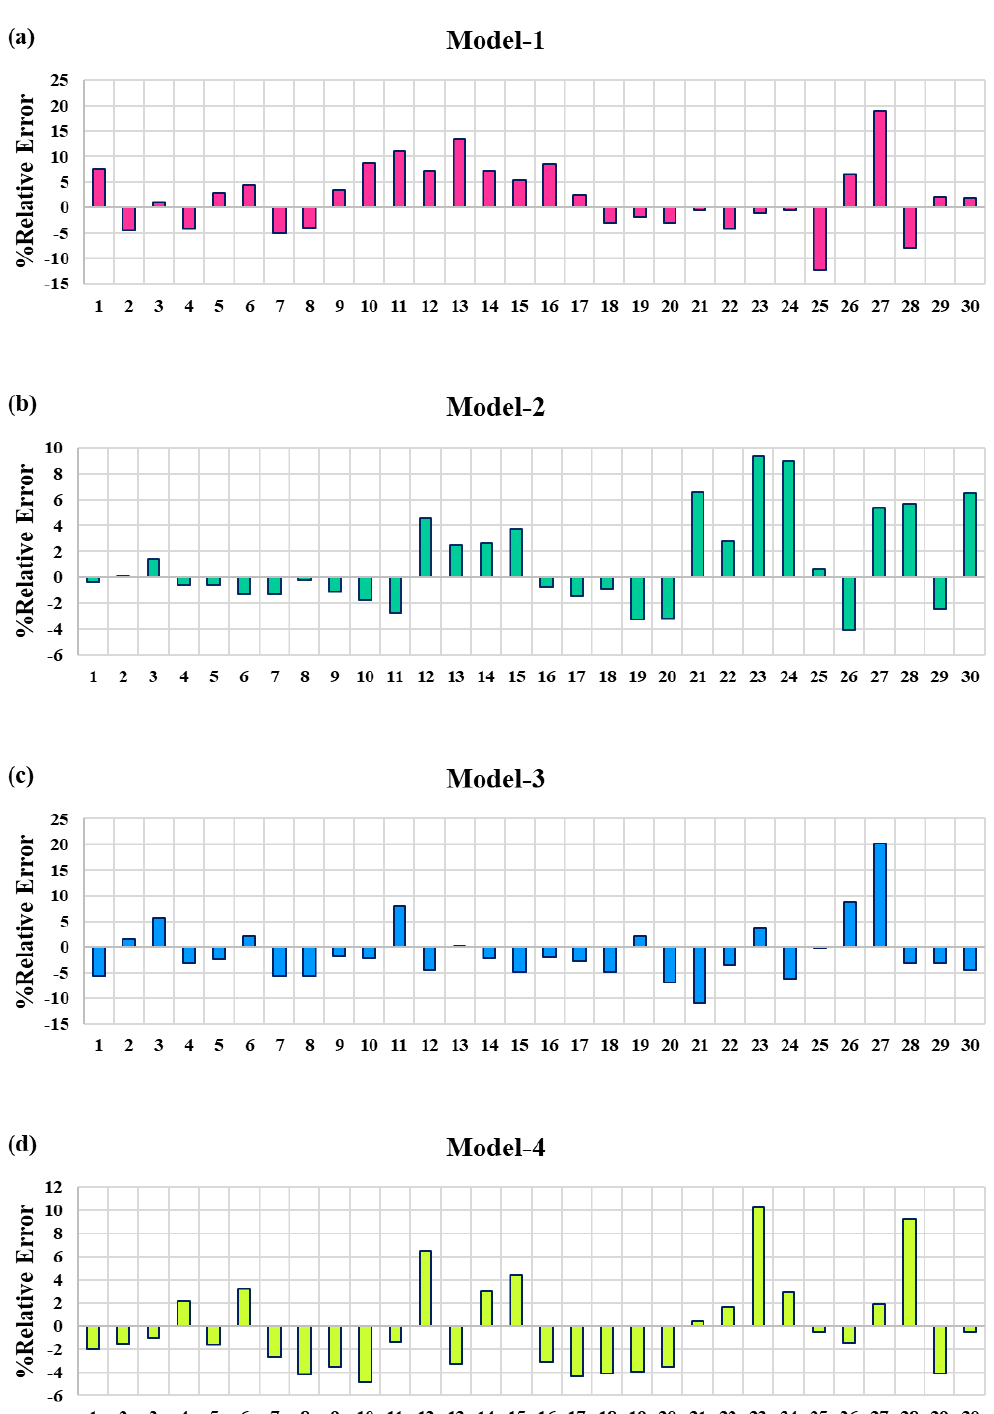
Figure 5. Distribution of the relative error through examination interval for all models using MLPNN method.